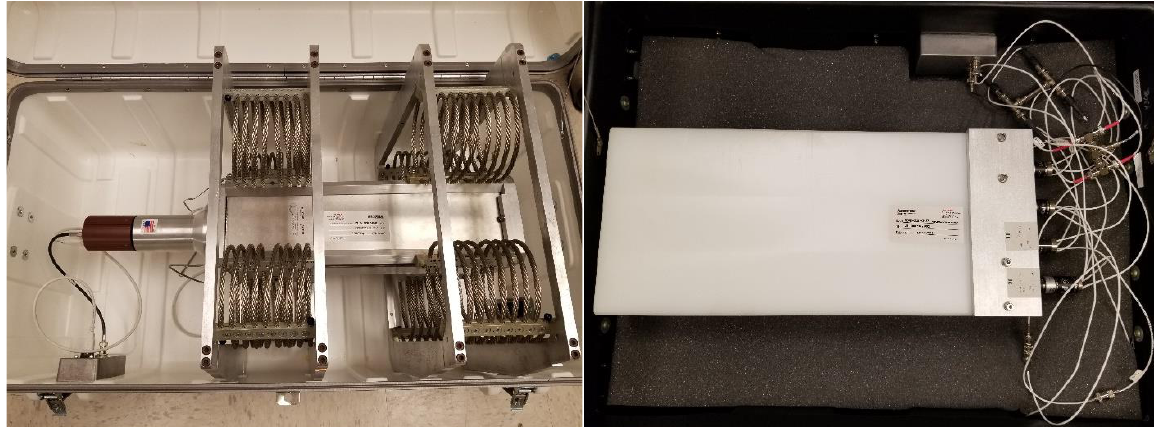
Figure 2. Photos of Ortec NAI-SS-4-P system in their ruggedized cases including the 4”-by-4”-by-16” NaI scintillation detector (left) and the four 3 He tubes in polyethylene moderator